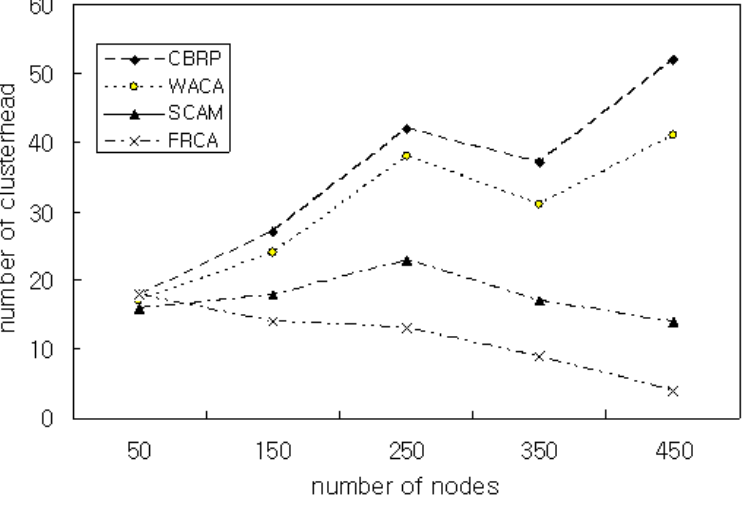
Figure 6. Number of clusterheads with the number of nodes N = 450 and  =